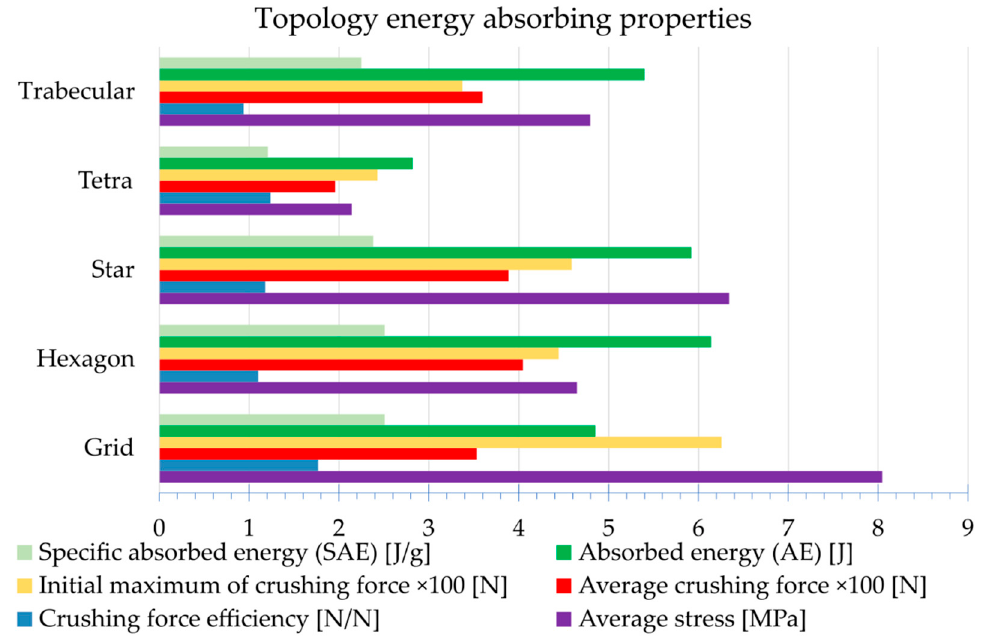
Figure 11. Graphical comparison of the energy absorbing parameters of the topologies studied.